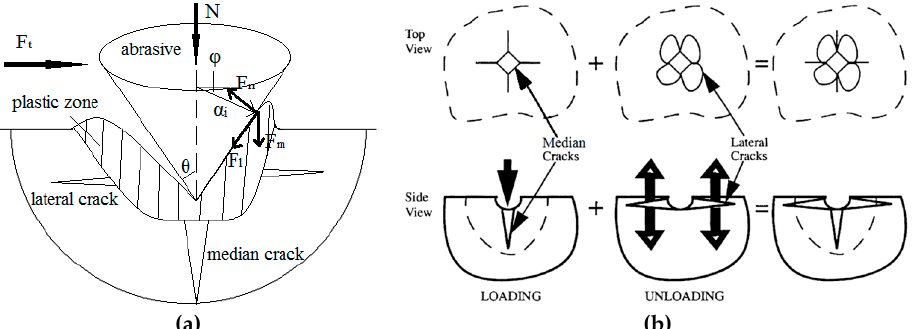
Figure 1. The force system and crack system of the contact process. ( a ) Force system of the contact process; ( b ) crack system of the contact process.